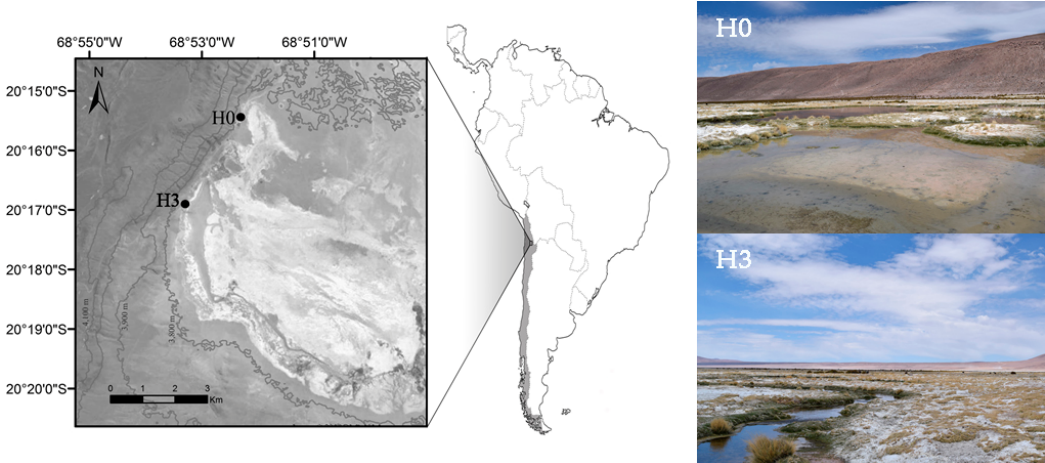
Figure 1. Map of Salar de Huasco, Chile, showing the location of both sampling sites (i.e., H0 pond and H3 stream) sampled during dry season in November 10th, 2015.